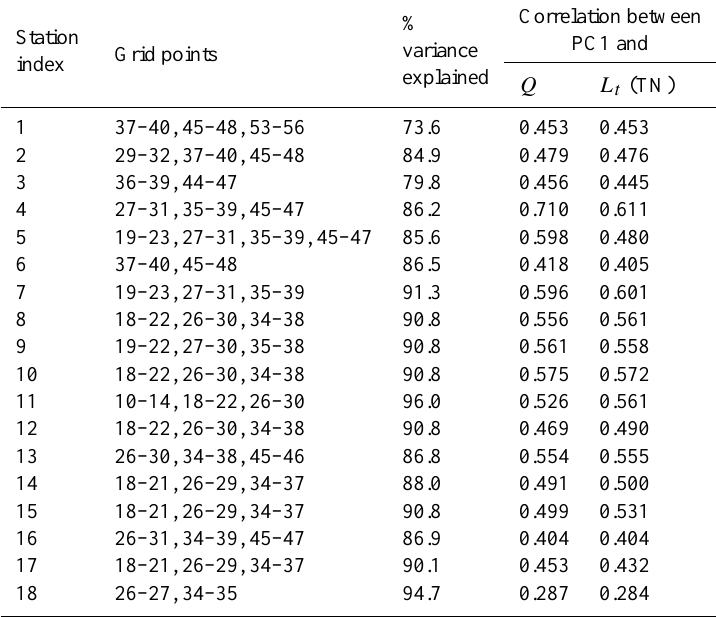
Table 3. Rank correlation between observed winter streamflow, TN loadings with the first principal component of the winter precipitation forecasts for the 18 selected stations. Locations of grid points indicated in the Table are shown in Fig. 1. % Correlation between Station PC1 and Grid points variance index explained Q L t